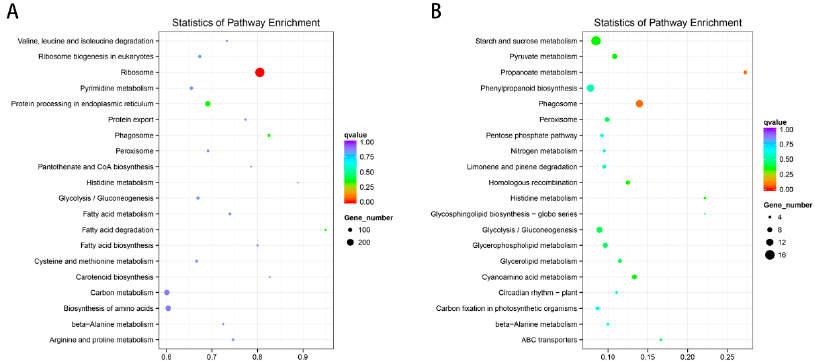
Figure 12. GO analysis of miRNAs in the cultivar “Huoche” under heat stress. The histogram of GO enrichment analysis of DE miRNA targeted mRNAs. The ordinate is the enriched GO term, and the abscissa is the number of di ff erentially expressed genes in this term. Di ff erent colors are used to distinguish biological processes, cellular components and molecular functions.